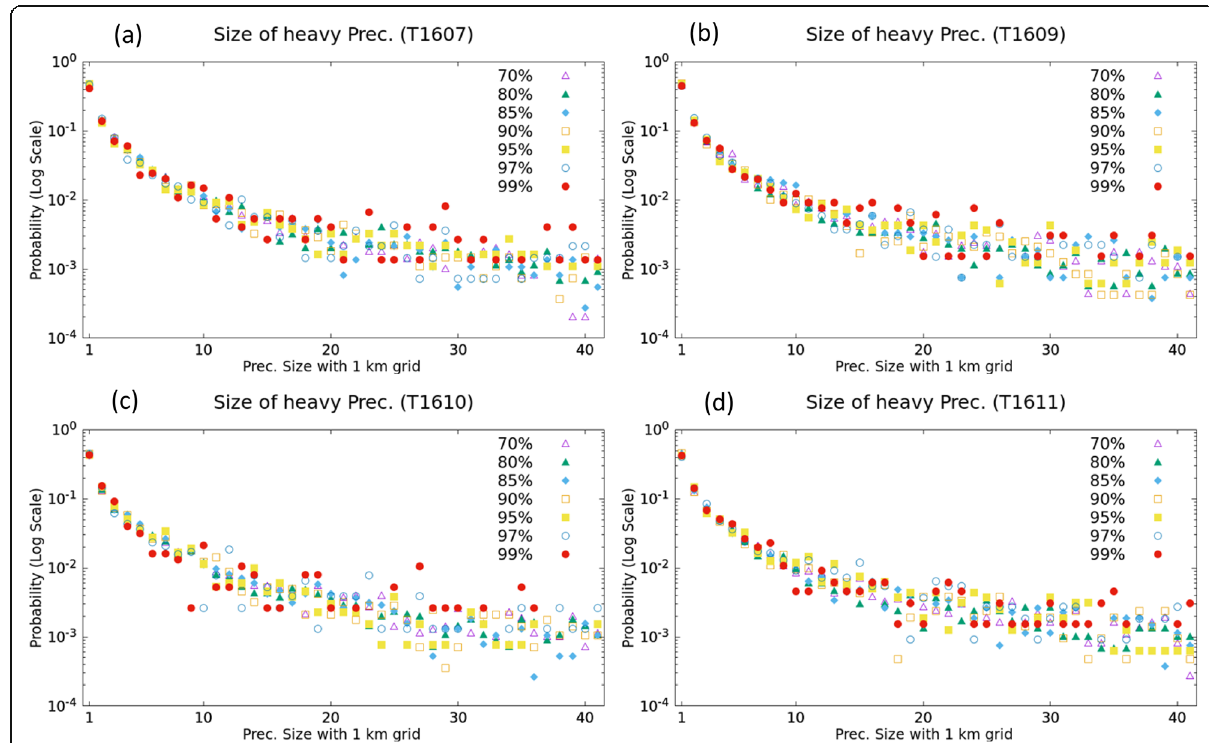
Fig. 5 Size of heavy precipitations with different thresholds from a Typhoon Chanthu, b Typhoon Mindulle, c Typhoon Lionrock, and d Typhoon Kompasu. Results correspond to the